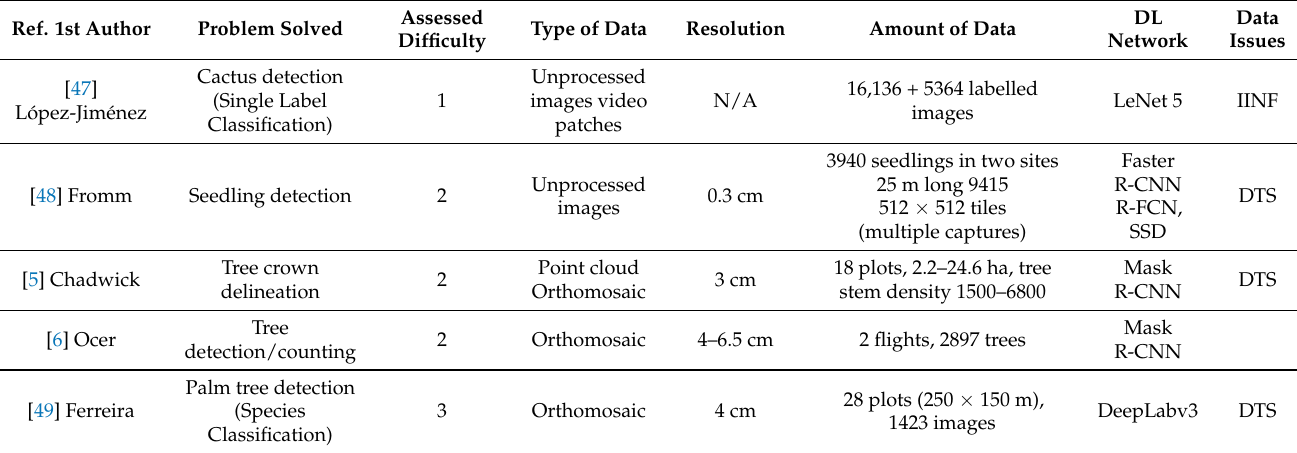
Table 2. Summary of Papers reviewed addressing Individual tree detection using DL. N/A stands “Not Available”. Regarding the “Data Issues” column, the following notation is used: “Wrong Split” (WS), “Late Split” (LS), “validation set for testing” (VST), “dependent test set”(DTS) or “insufficient information” (IINF); see Section 3 for